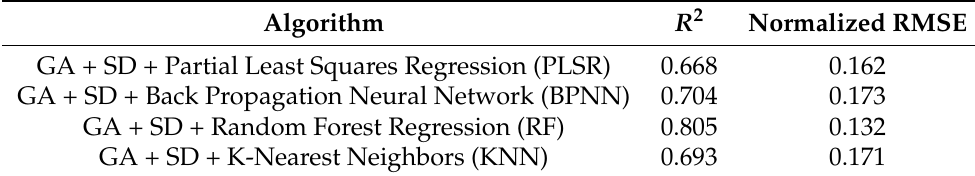
Table 4. Table of the comparison of the R 2 and nRMSE values of the four regression-based machine learning algorithms tested for bare soil arsenic detection using the GA-Generated 10 characteristic wavelengths. Refer to the abbreviations section at the end of the paper for full technique